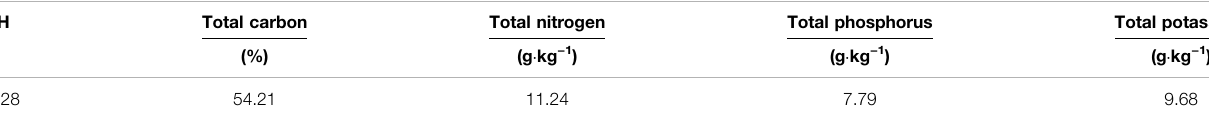
TABLE 2 | Biochar basic nutrient property.